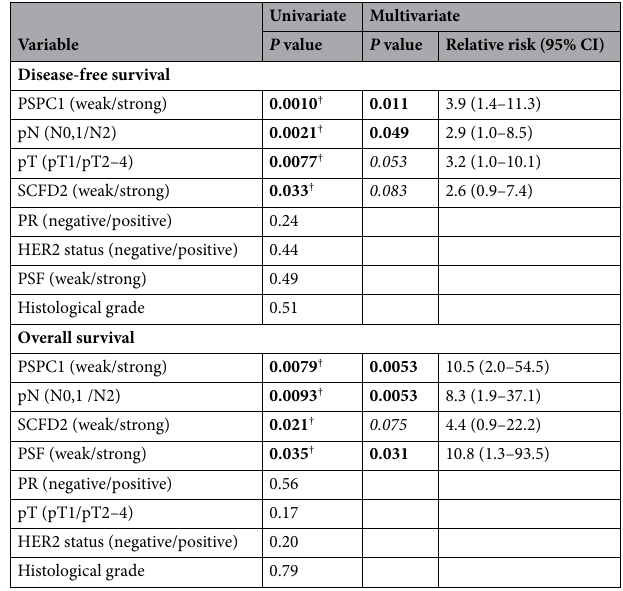
Table 2. Univariate and multivariate analyses of disease-free and overall survivals in 114 ER-positive breast cancer patients. Statistical analysis was evaluated by a proportional hazard model (Cox). P value < 0.05 and 0.05 ≤ P value < 0.10 were considered significant and borderline significant, and were listed in bold and italic, respectively. 95% CI 95% confidence interval. † Significant ( P < 0.05) values were examined in the multivariate analyses in this